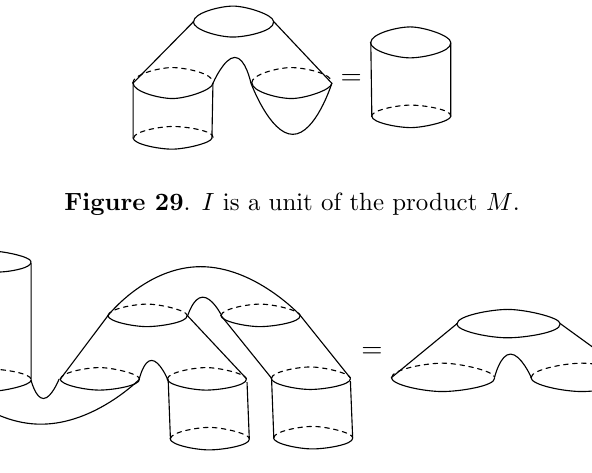
Figure 30 . The product is invariant under exchanging an incoming circle and an outgoing